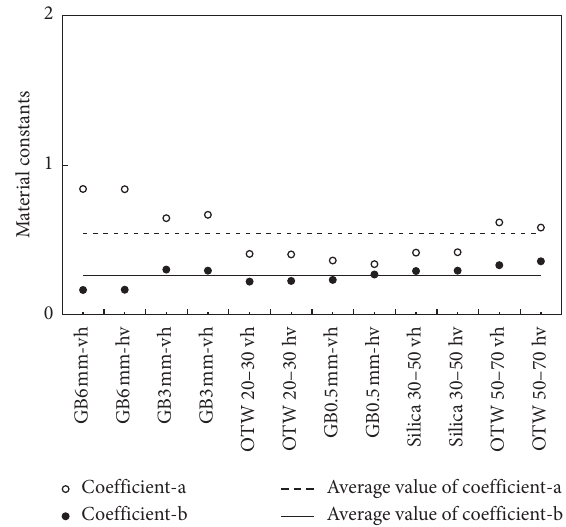
Figure 10: The fitting parameters of “ a ” and “ b ” based on equation (9) for all the test materials.